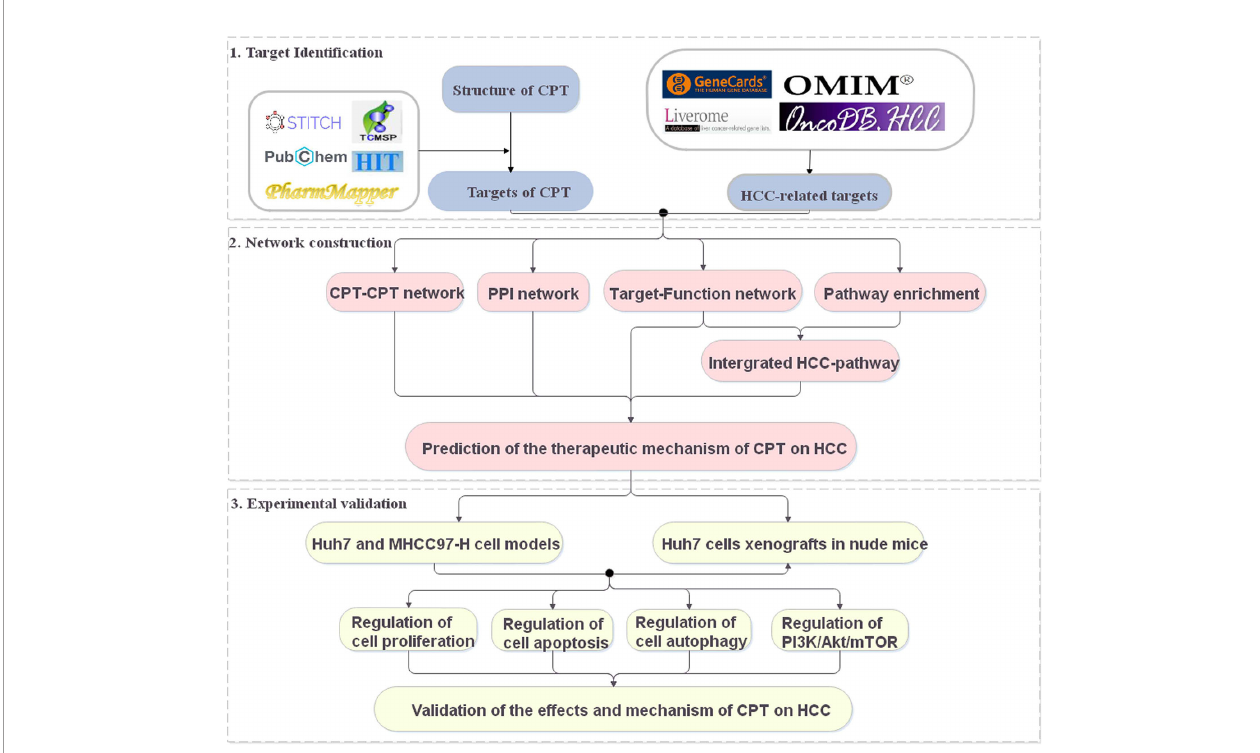
FIGURE 1 | A schematic diagram showing the systems pharmacology approach for investigating the therapeutic mechanisms of cryptotanshinone (CPT) on human hepatocellular carcinoma (HCC) by integrating target identi fi cation, network analysis, and experimental